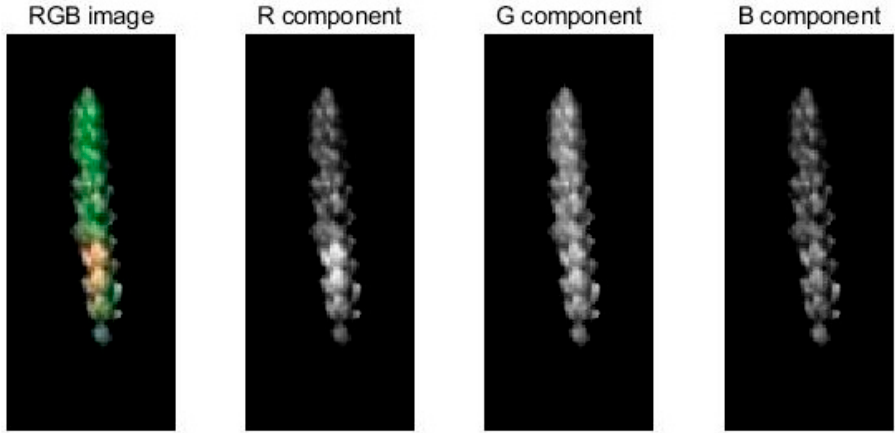
Figure 8. Results of three components of wheat ear samples: R, G, and B.